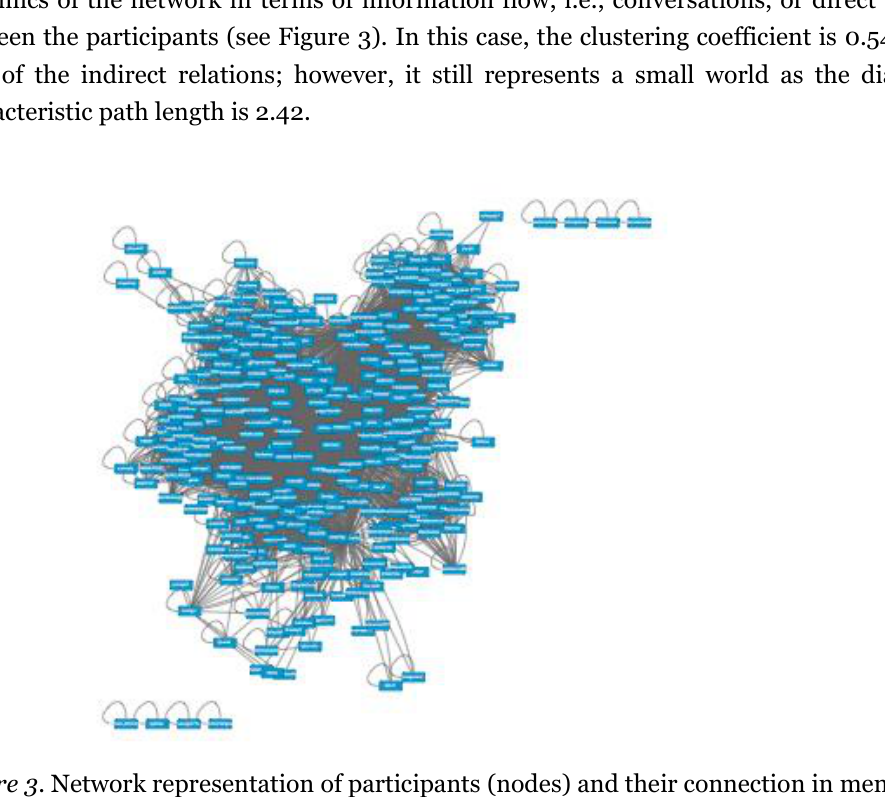
Figure 3 . Network representation of participants (nodes) and their connection in mentions (edges). Within the conversation-based network we identified 39 clusters, with eight of these clusters being bigger than 20 participants. The representation of in-degree distribution (Figure 4A) and out-degree distribution (Figure 4B) evidenced that a single member receives information from a big group of members (receiving more than 170 inputs) and that ten people communicate to a big group of people (around 80 outputs). Around 60 people scarcely receive or send tweets to other members. The conversational archetype in this case also corresponds to a community clusters archetype (Smith et al.,